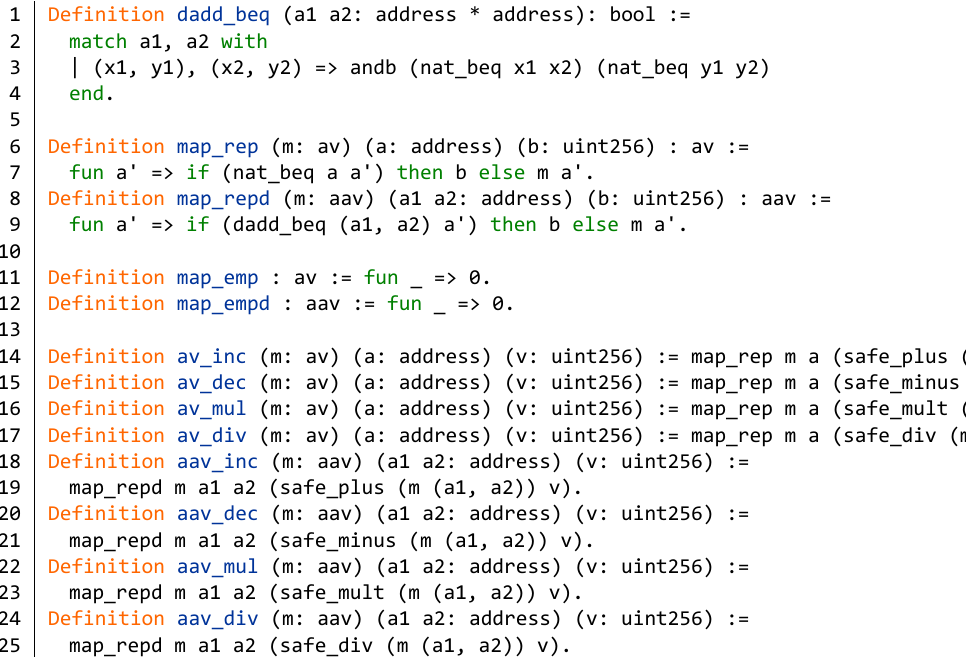
Figure 6. Definitions of safe operators on mapping.